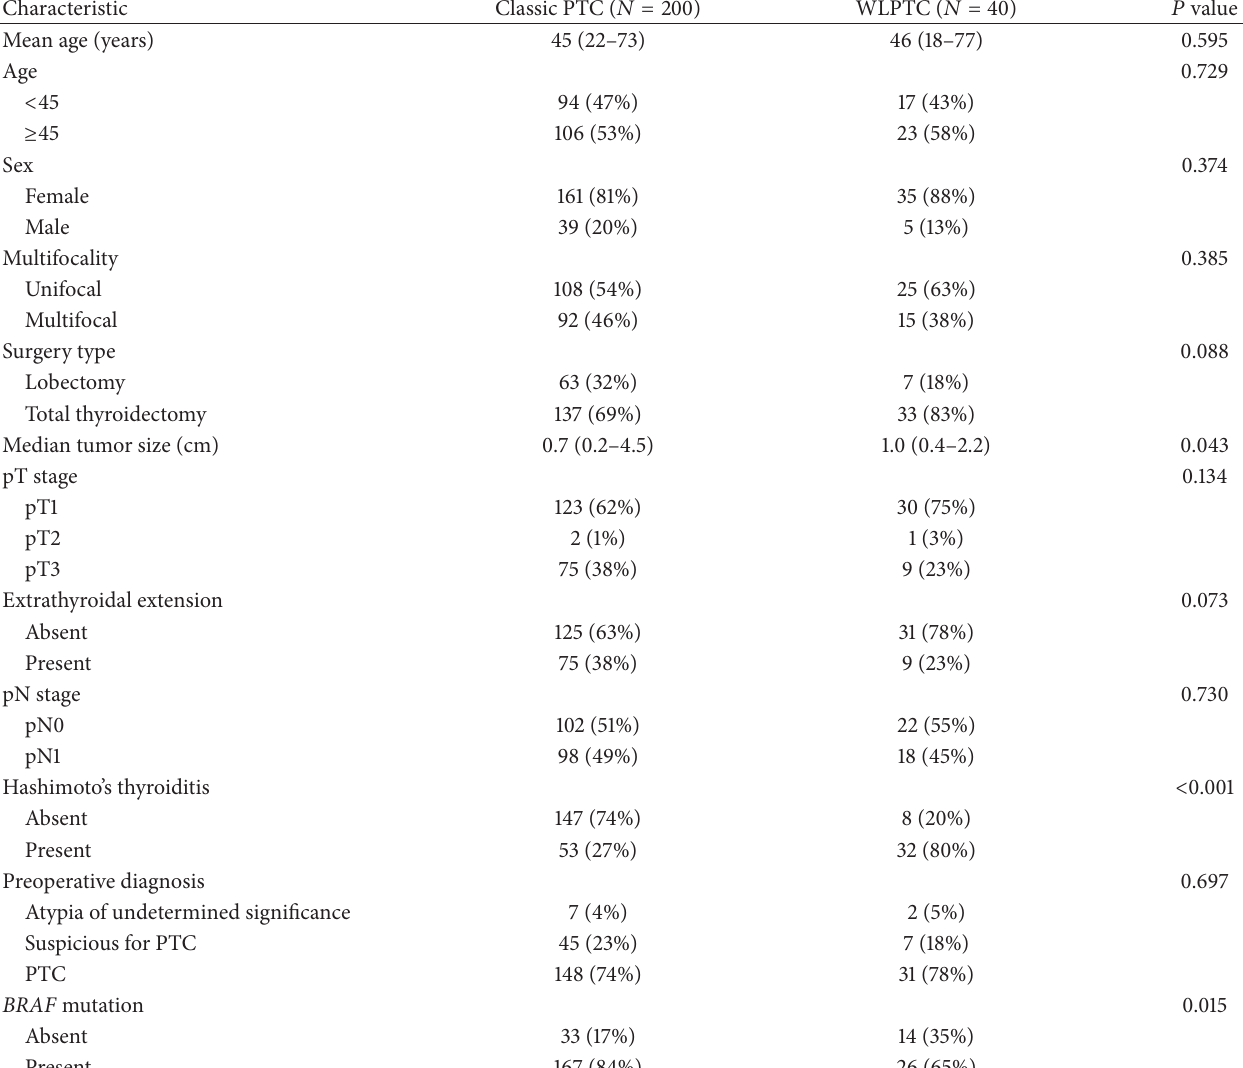
Table 1: Comparison of clinicopathologic characteristics between WLPTC and classic